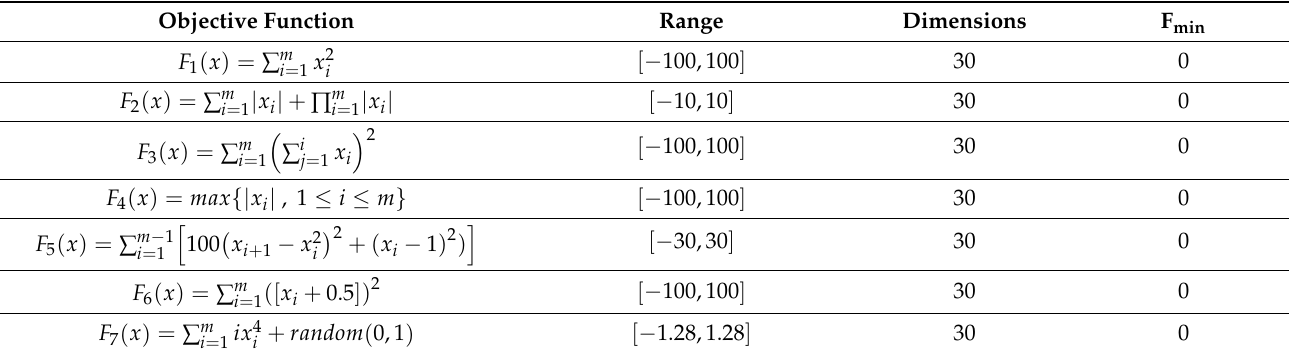
Table A1. Unimodal test functions.